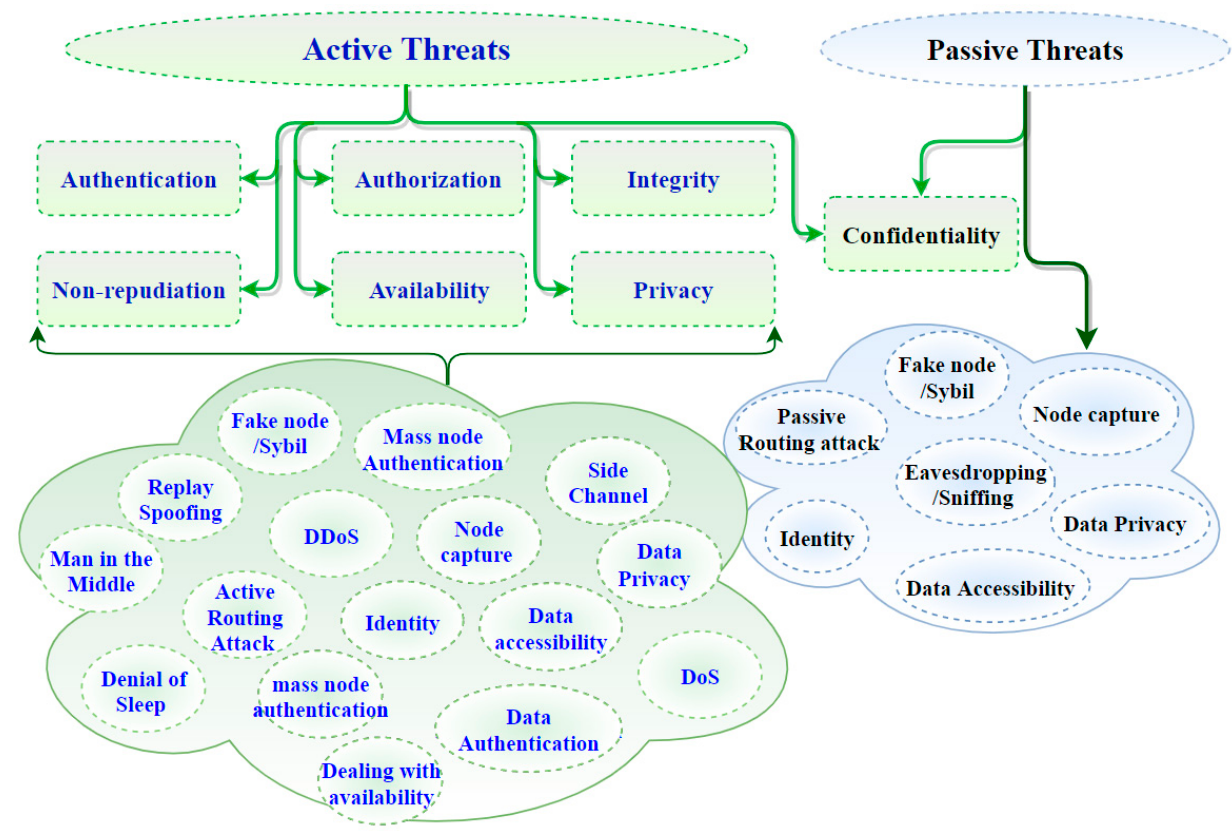
Figure 2. Passive and active threats in the IoT system.